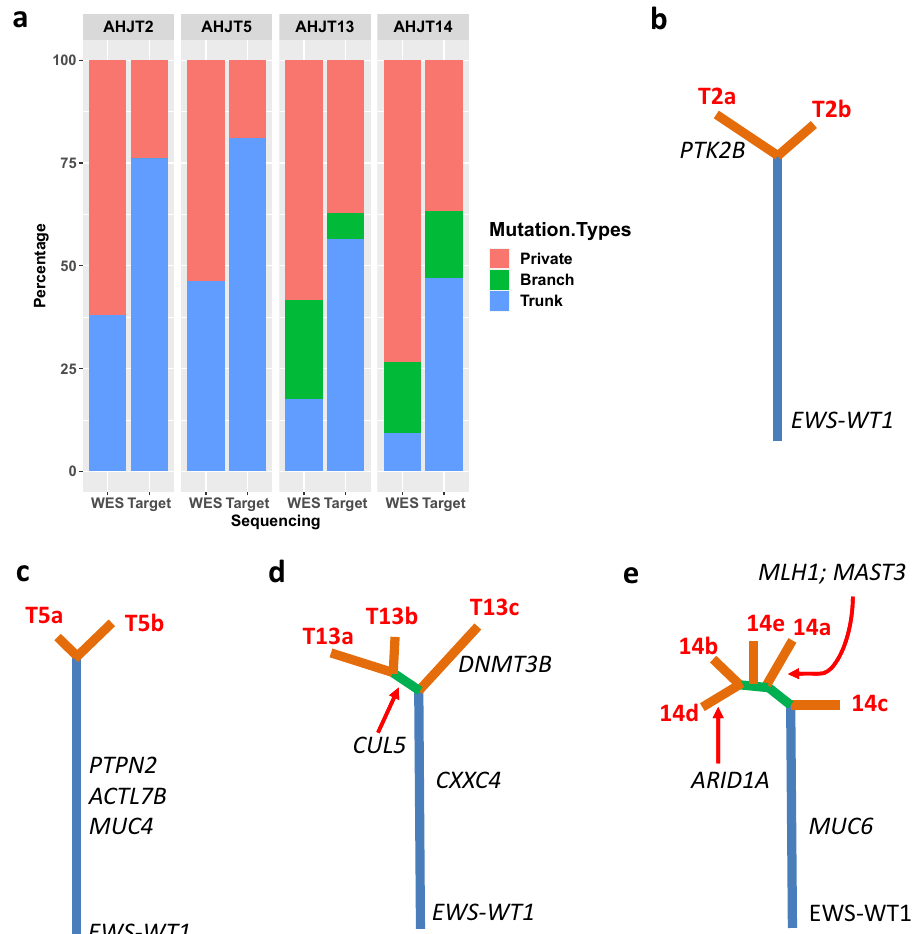
Fig. 3 Tumor Heterogeneity analysis of DSRCT samples. a Distribution of trunk, branch, and private branch mutations de fi ned by WES and targeted deep sequencing. b – e Mutation phylogenetic trees of patients AHJT2T, -5, -13, and -14. Blue, green, and orange lines of the phylogenetic trees represent trunk, branch, and private branches respectively. The mean allelic frequency to trunks of the four phylogenetic trees are respectively 0.209, 0.234, 0.169, and 0.156 while the mean allelic frequency to branches (including privates) of the trees are respectively 0.126, 0.125, 0.142, and